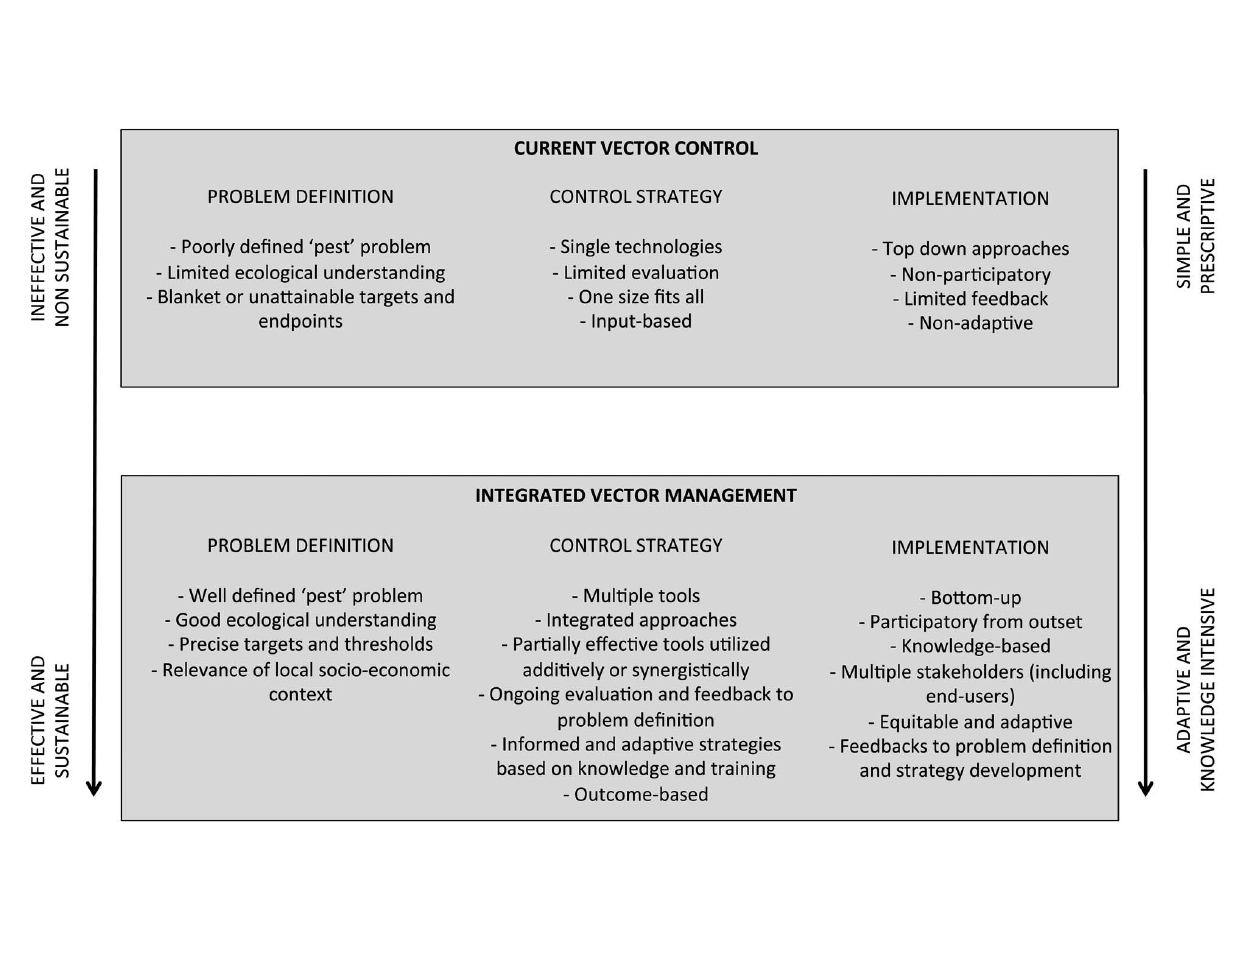
Figure 1. Features of current vector control strategies compared with potential integrated vector management (IVM). The arrows indicate trends representative of the contrasting strategies. Progression towards IVM has the potential to increase the effectiveness and sustainabilty of control, but requires more diverse and knowledge-intensive approaches.